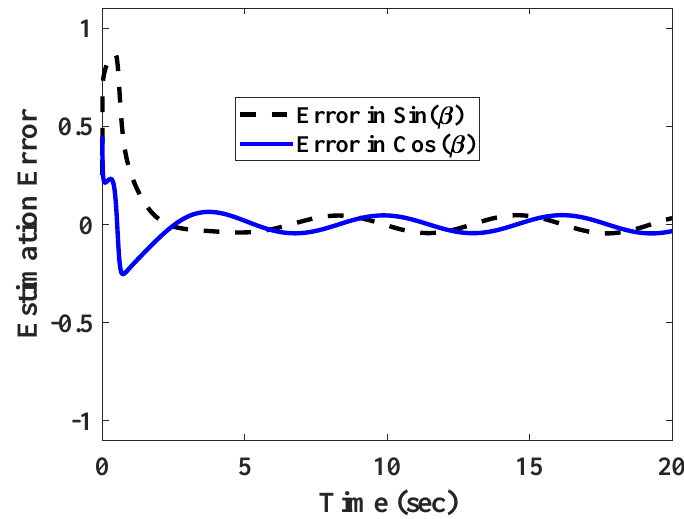
Figure 7. Estimation error in presence of fast varying of measurement errors.